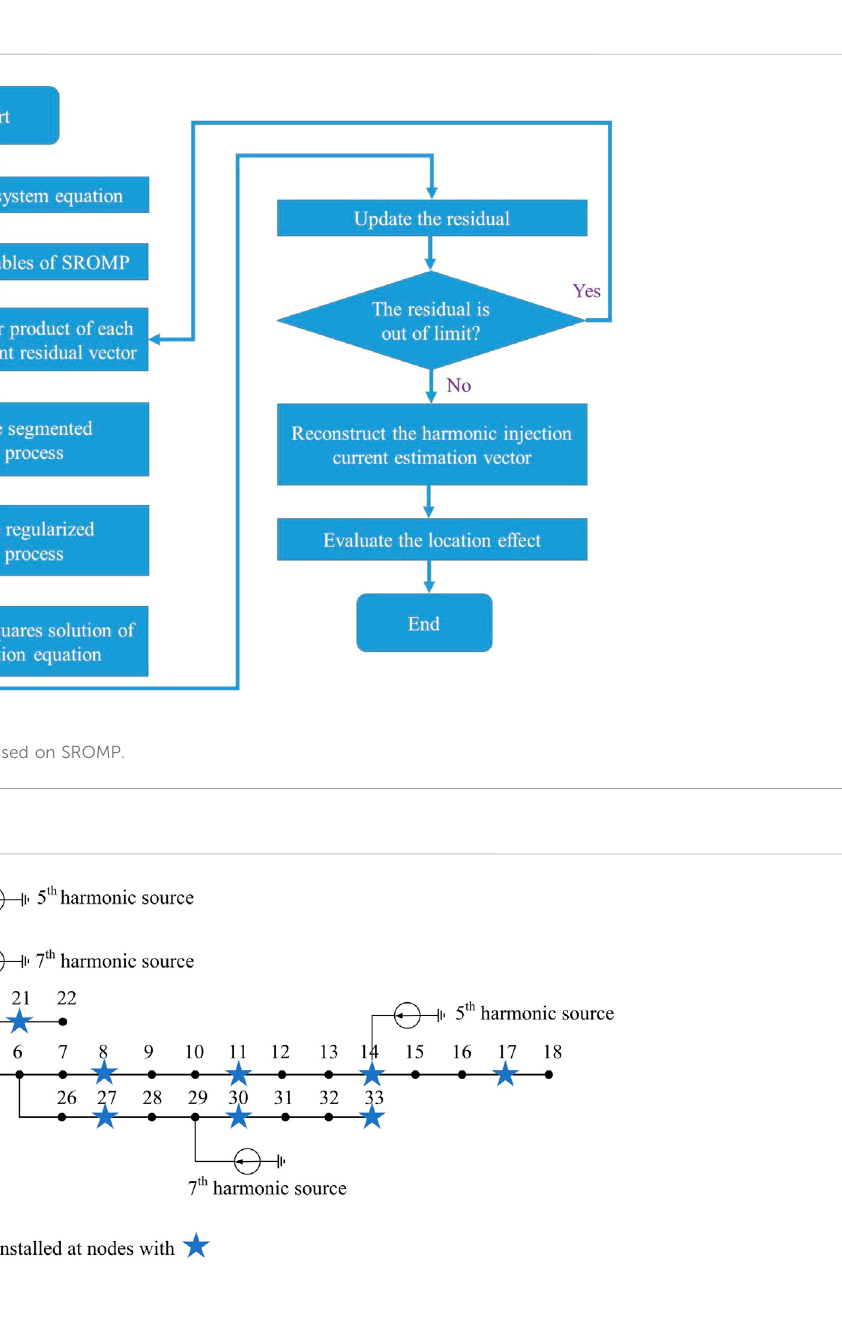
FIGURE 3 Improved IEEE-33 node